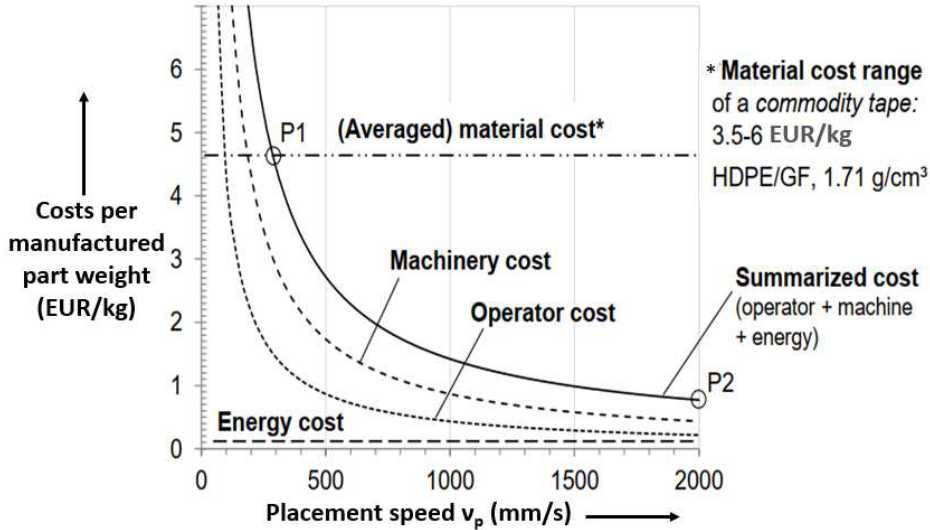
Figure 6. Breakdown of costs per produced part weight for various placement speeds [144].